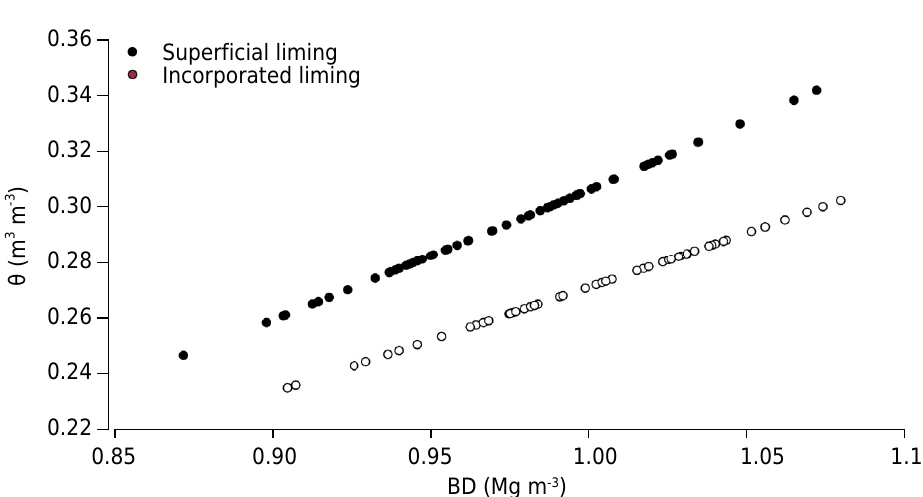
Figure 4. Water content (θ) at which soil penetration resistance (PR) becomes critical (2 MPa) for surface liming and incorporated